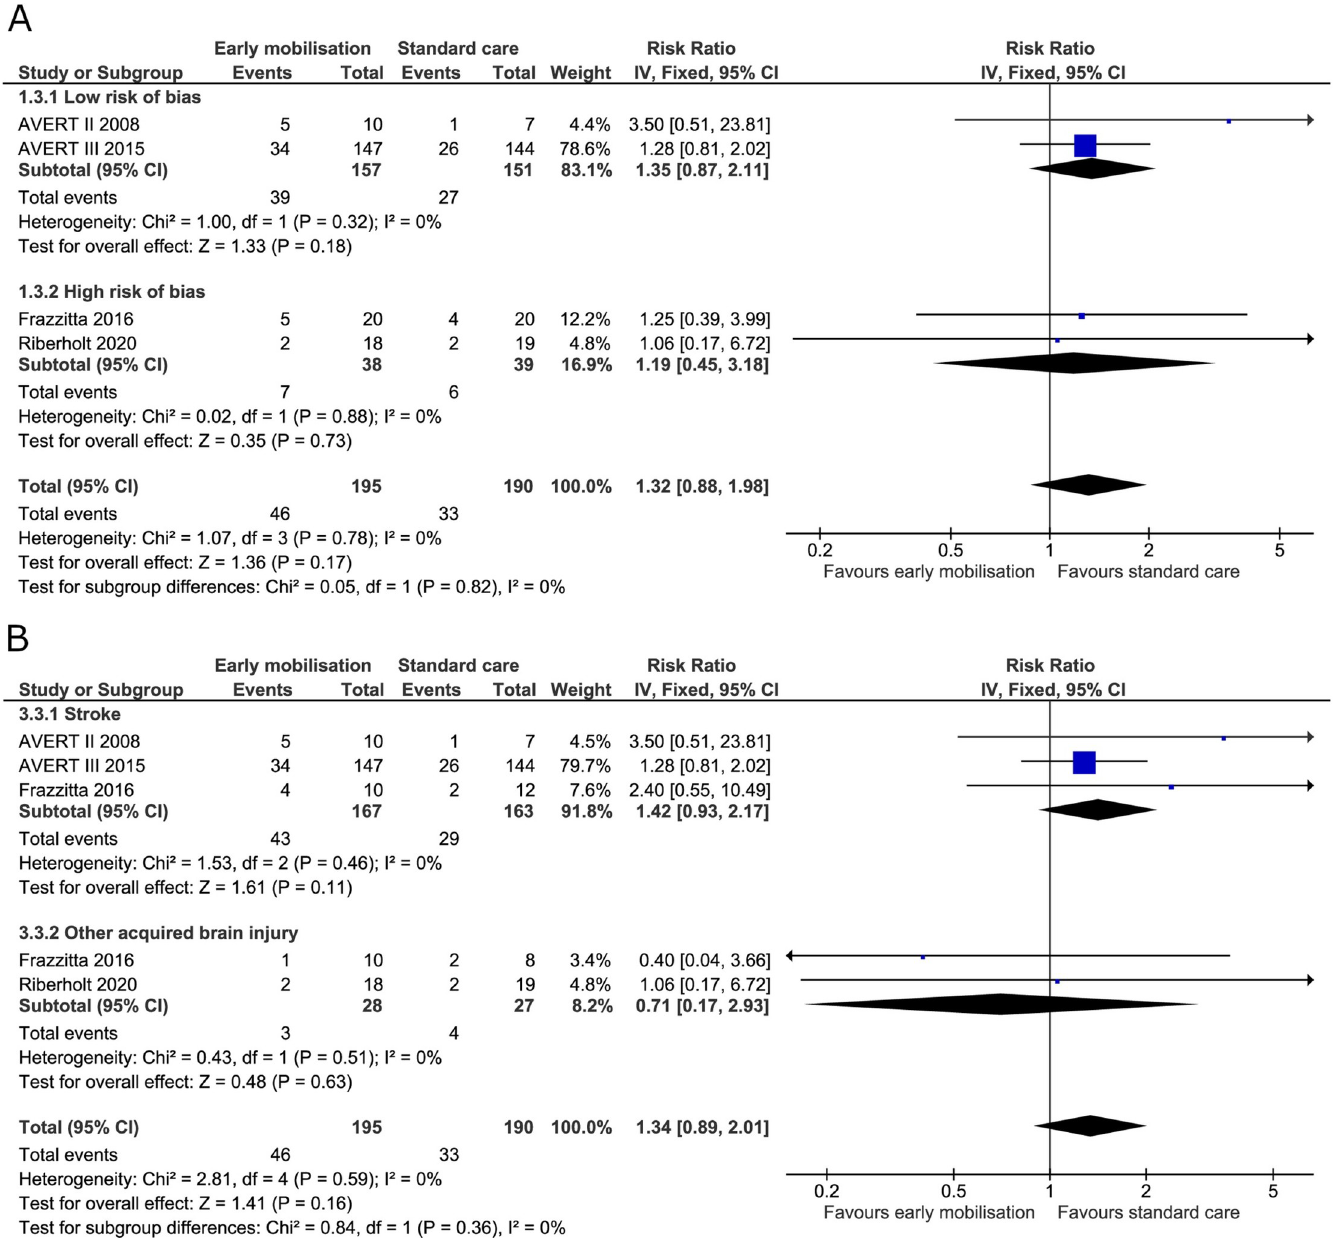
Fig 6. Comparison of early mobilisation versus standard care–mortality at the end of the intervention. Fig 6A and 6B. Forest-plots showing the results from the fixed-effect meta-analysis of the outcome mortality at end of intervention with subgroup divided according to risk of bias (A) or diagnosis (B).